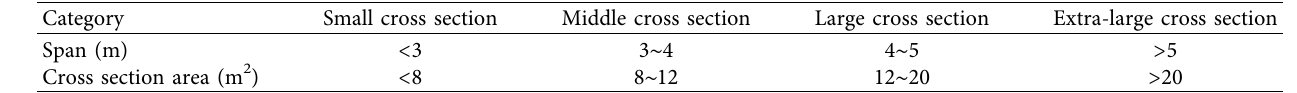
Table 4: Roadway classification standards by the span and section area.